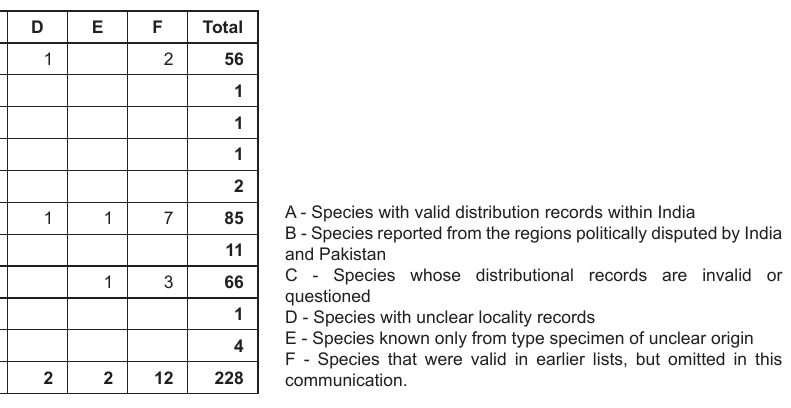
Table 2. Family wise categorization of Indian lizard species based on distributional records